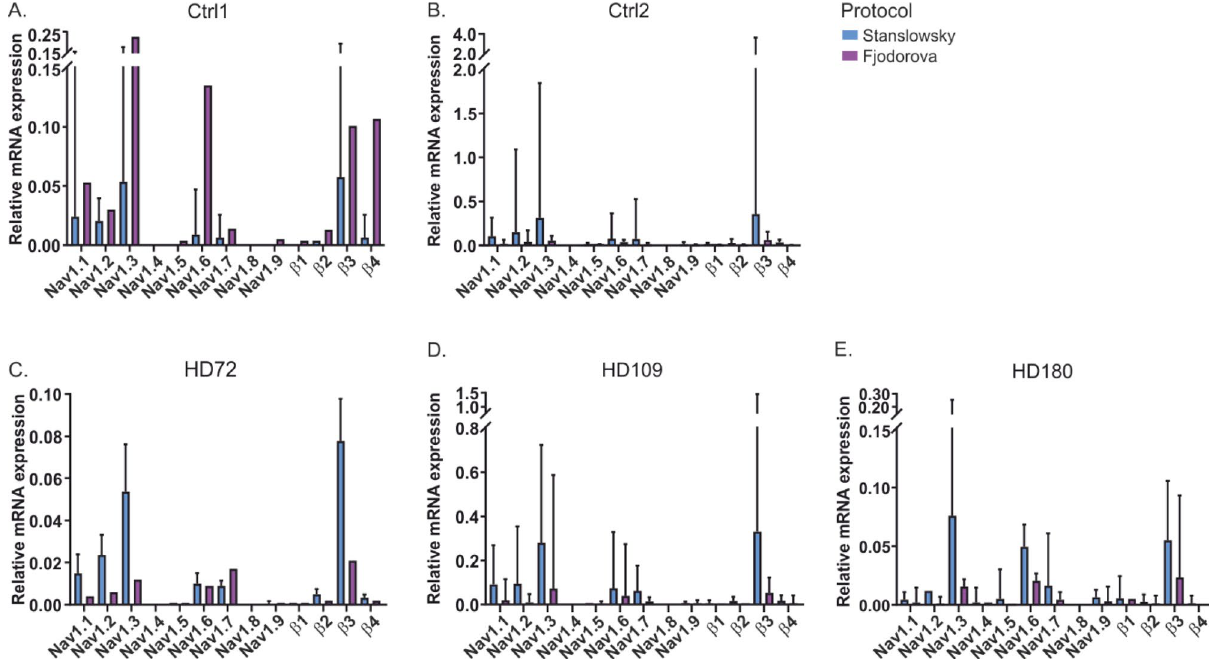
Figure 5. RT-qPCR of the nine Nav α and the four Nav β subunits from each iPSC-derived neuron lines of the Stanslowsky (blue) or the Fjodorova (purple) protocol. ( A - B ) RT-qPCR of Ctrl1 ( A ) and Ctrl2 ( B ) neurons. ( C - E ) RT-qPCR of HD72 ( C ), HD109 ( D ) and HD180 ( E ) neurons. Error bars denote 95% confidence interval. Number of differentiations for the Stanslowsky protocol: n = 2 for Ctrl1, n = 2 for Ctrl2, n = 3 or HD72, n = 2 for HD109, n = 2 for HD180 and for the Fjodorova protocol: n = 1 for Ctrl1, n = 3 for Ctrl2, n = 1 or HD72, n = 2 for HD109, n = 2 for